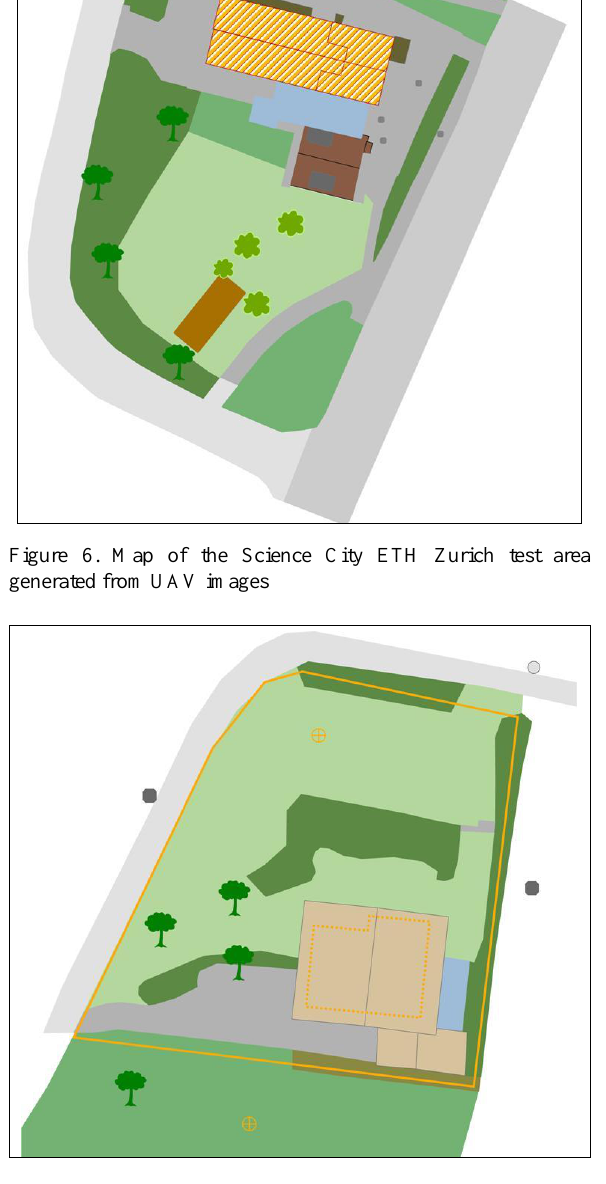
Figure 7. Map of the Krattigen test area generated from UAV